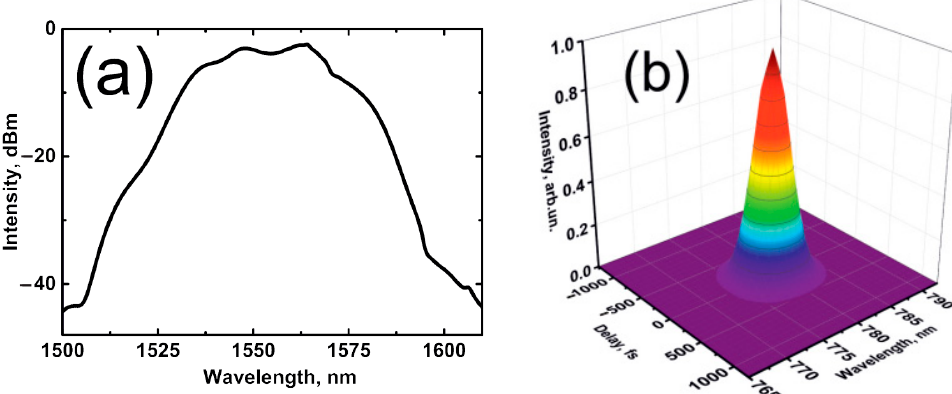
Figure 7. ( a ) Optical spectrum and ( b ) SHG FROG trace of the pulse profile.